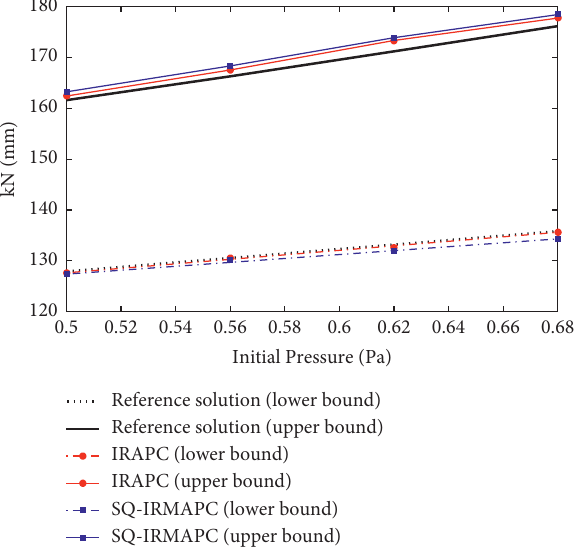
Figure 4: An air spring.